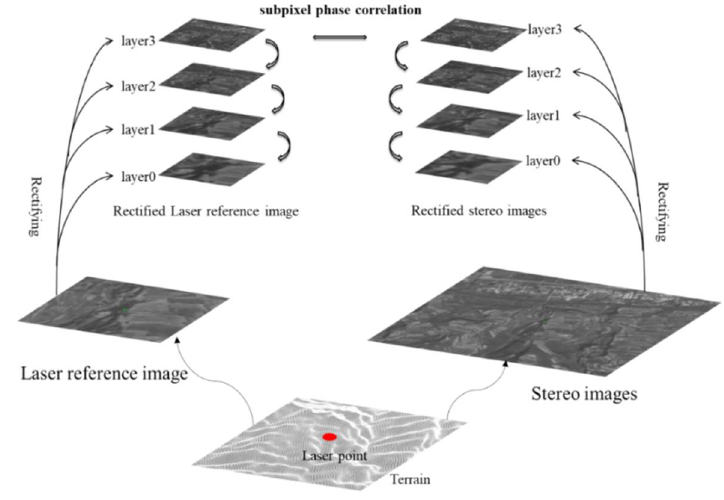
Figure 4. Geographic pyramid registration method of laser altimetry data and stereo images.